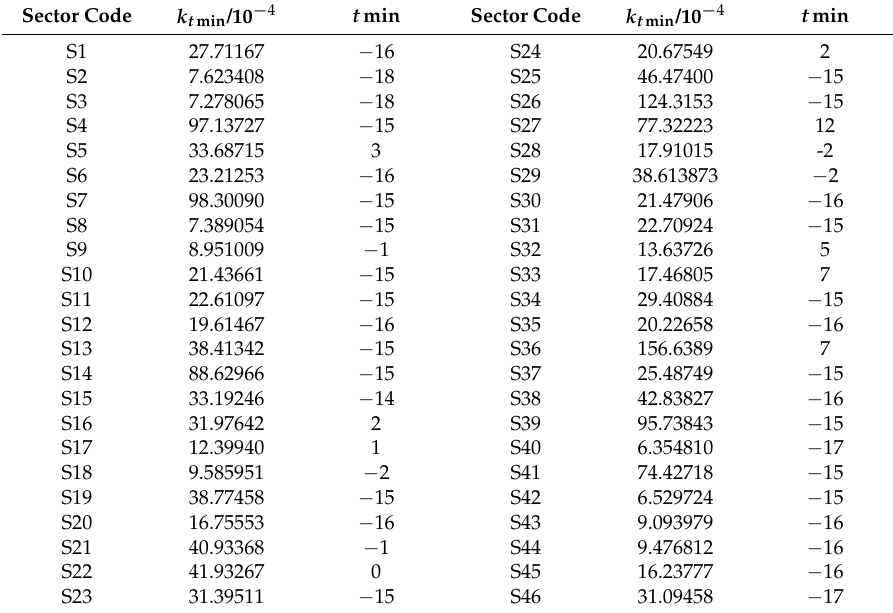
Table 2. The minimum value of Kullback-Leibler (KL) divergence and corresponding term.